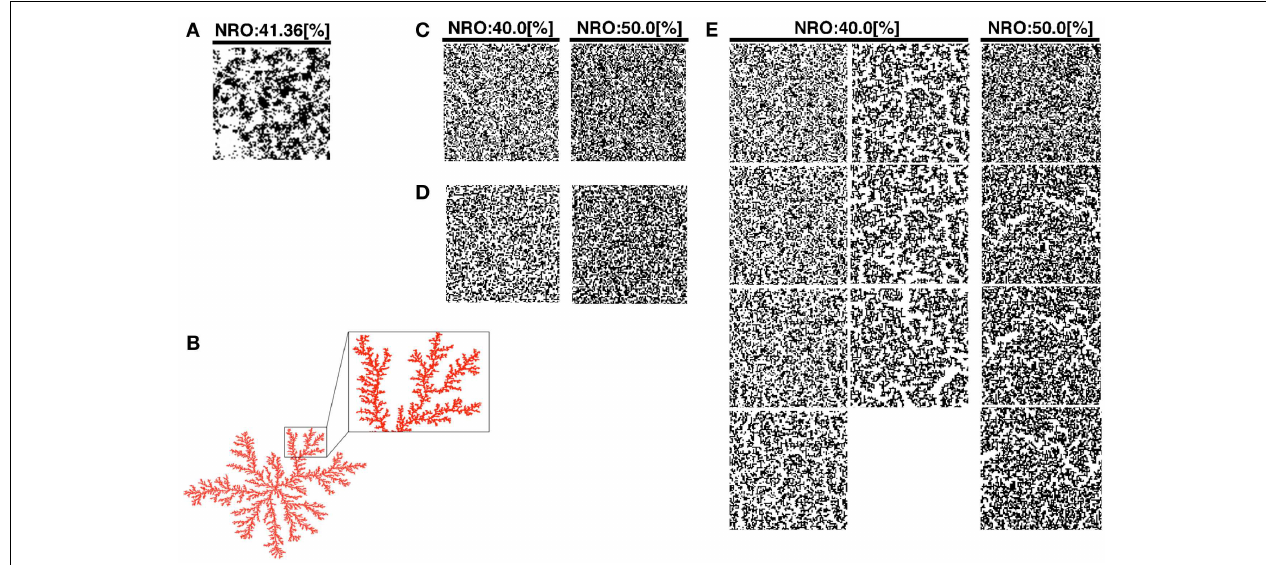
structure in the left panel consists of 40% of NRO.The structure in the right panel consists of 50% of NRO. (E) The simulated structure of CCA.The left two lanes of panels consist of 40% of NRO. Panels in the lanes respectively show the structure at the 100th step, 300th step, 500th step, 700th step, 900th step, 1,000th step, and 2,000th step of each simulation.The right lane panels consist of 50% of NRO. Each panel in the lane respectively shows the structure at the 100th step, 300th step, 500th step, and 700th